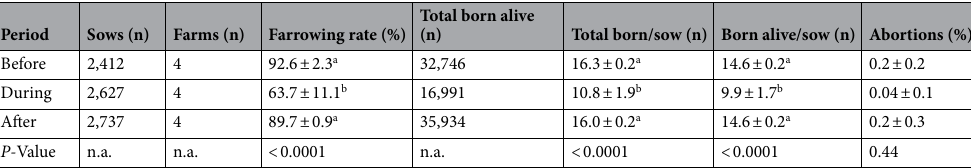
Table 1. Percentage of farrowing rate in sows and litter size of piglets in four sow farms in Croatia before, during and after using MEDI NOVA bags. Significant differences between the time-points are marked by the superscript index letters (a & b). Values are represented as mean ± SD. P values: ANOVA/Fisher LSD Test.